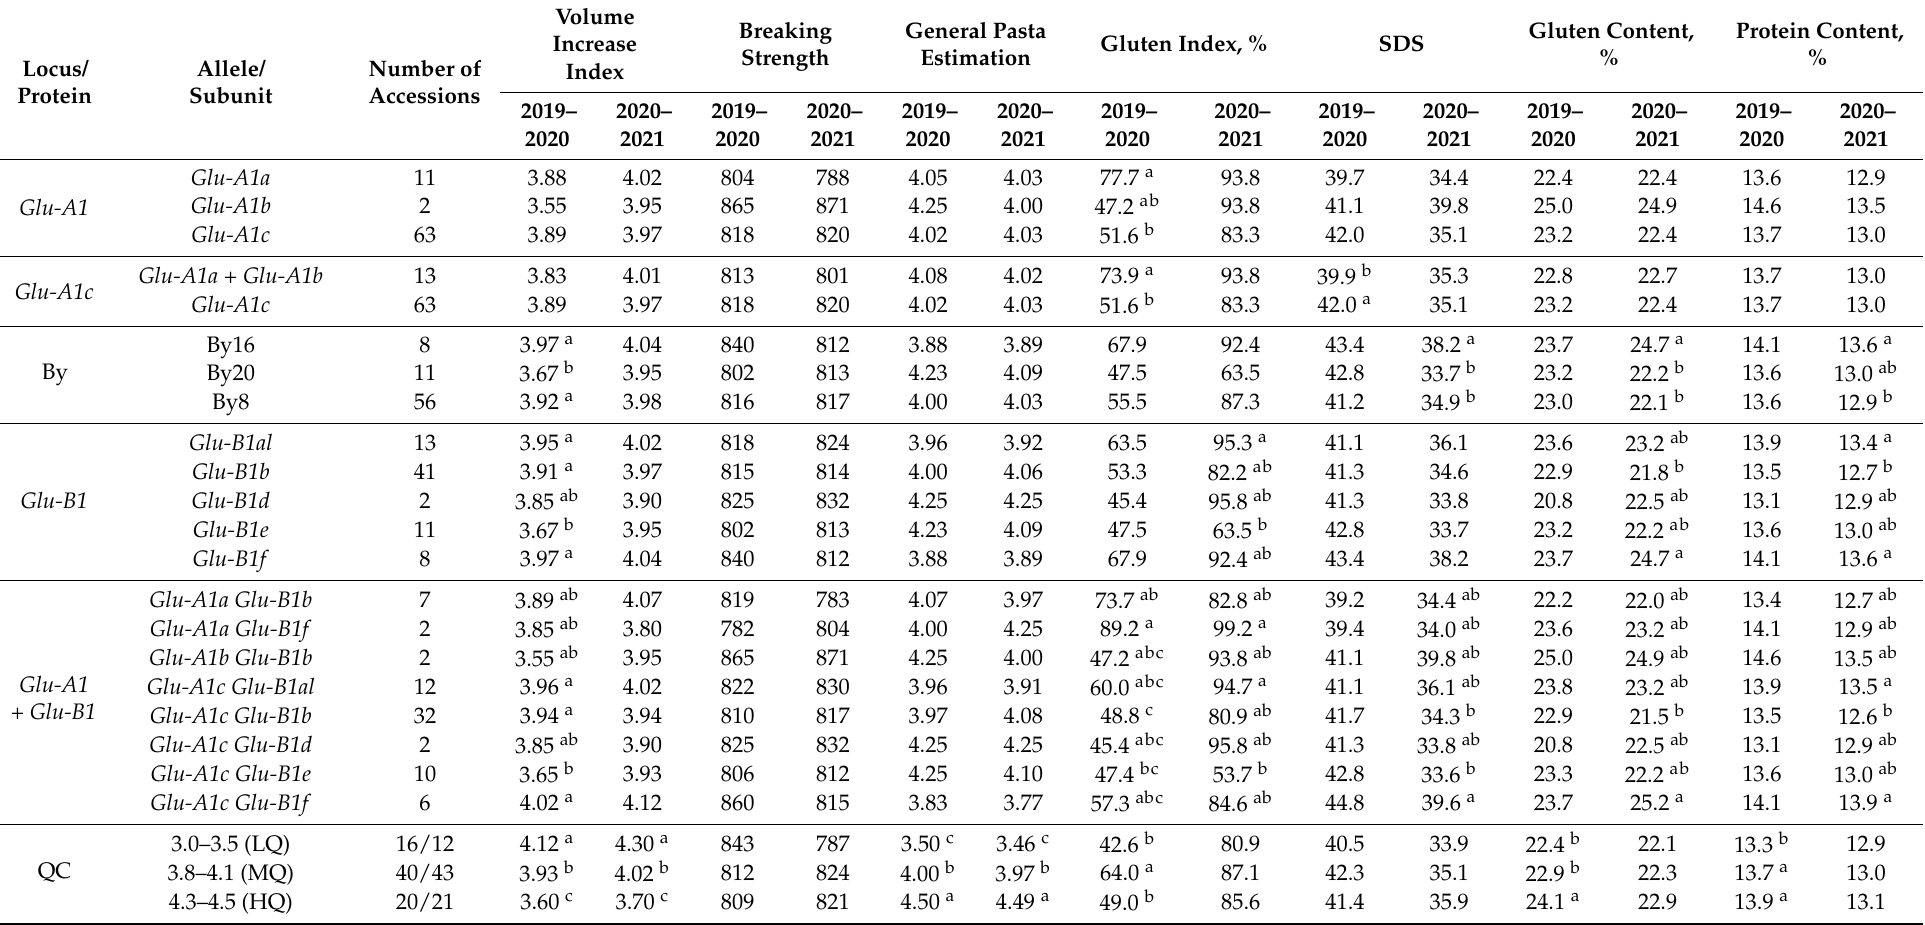
Table 2. Mean values of quality traits of 76 winter durum wheat accessions. Mean values designated with the same letters have no significant differences within each group, as calculated using Tukey’s criterion. For quality category (QC, HQ—high quality, MQ—medium quality, LQ—low quality), the number of accessions